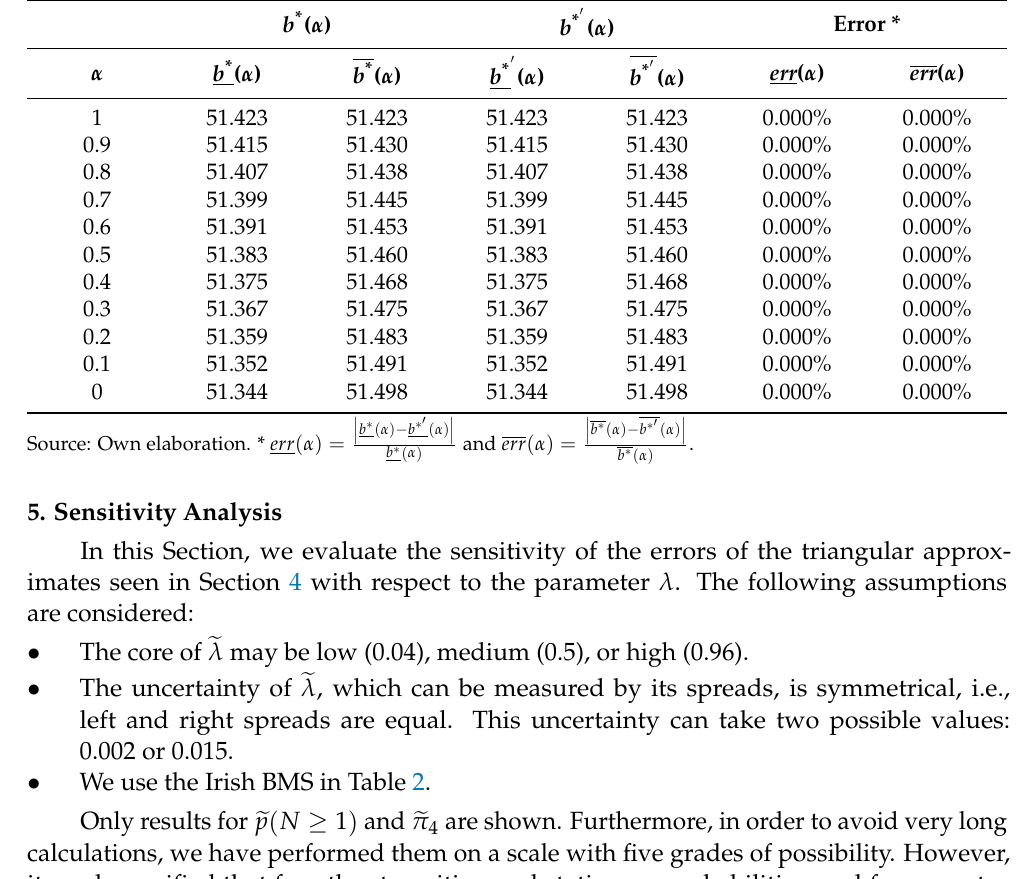
Table 6. α -cuts of (cid:101) b ∗ , it’s triangular approximate (cid:101) b ∗ (cid:48) and its